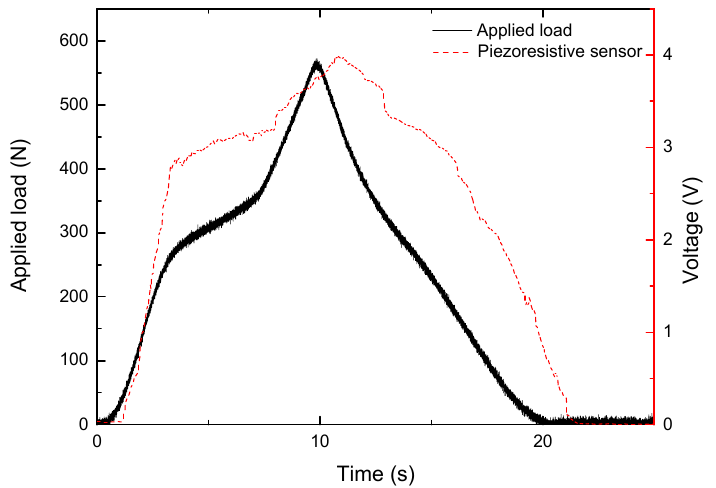
Figure 6. Applied load shape on the resistive sensor and response of the piezoresistive sensor to the applied load.